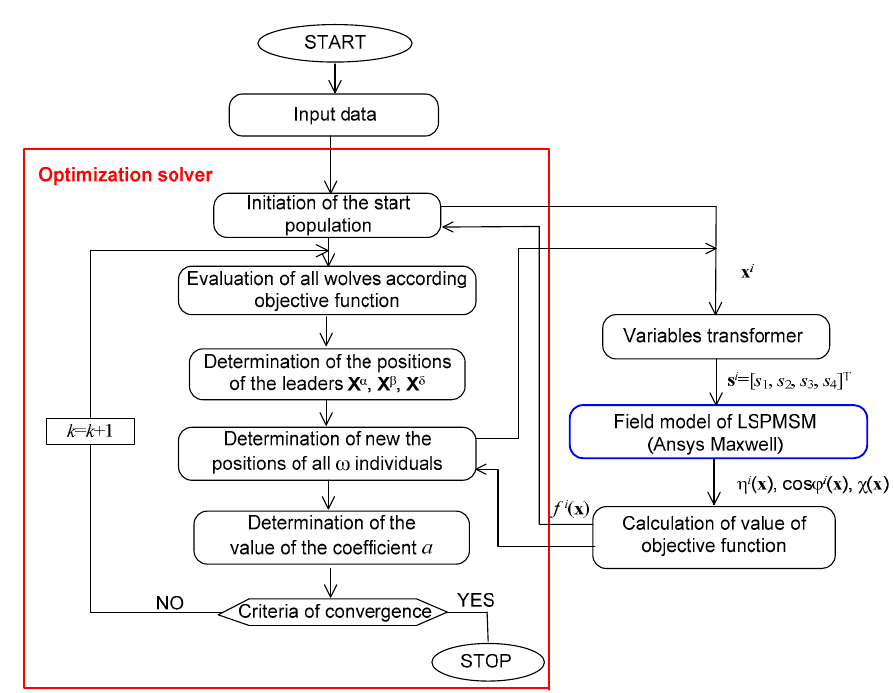
Figure 4. The flowchart of the elaborated in-house software.